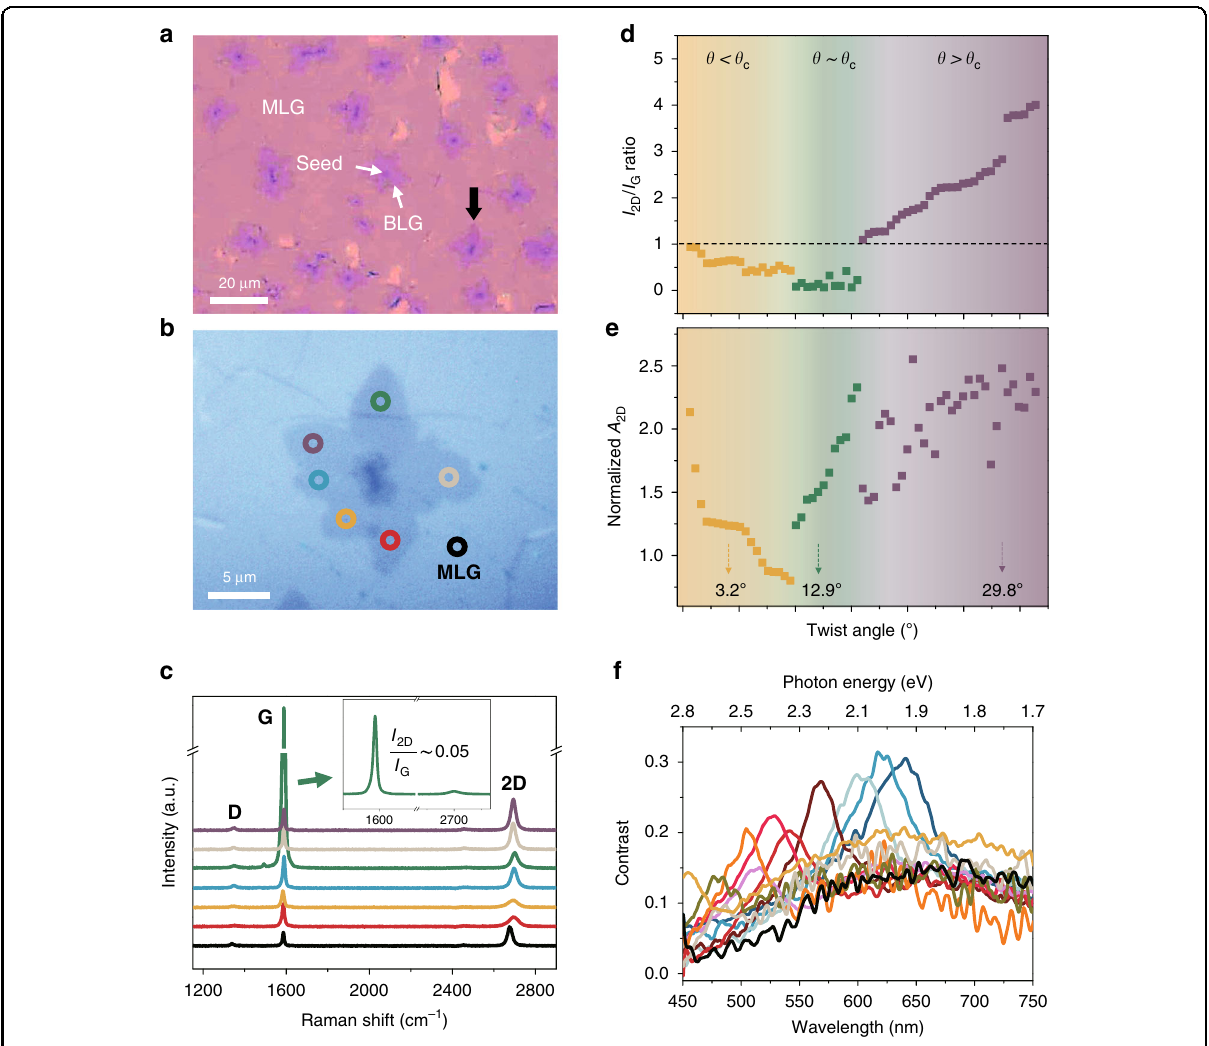
Fig. 1 Optical and Raman characteristics of CVD-grown tBLG. a Microscope image of CVD-grown graphene transferred onto a 300 nm SiO 2 /Si substrate. MLG covers most of the silica area with locally distributed star-shaped tBLG centred at the seeds (the darkest spots in the image). b Enlarged microscope image of the tBLG indicated by the black downward arrow in ( a ). Colour circles represent individual tBLG regions according to the twist angles. The black-circled region represents MLG. c Raman spectra of tBLG marked with the same colour as the circles in ( b ). Inset: Raman spectrum showing the full G- and 2D-bands in the green-circled tBLG in ( b ), where Raman G-resonance occurs from the interaction with the 532 nm excitation laser, indicating that the twist angle should be 12 ± 1° (refs. 29,33 ) (the critical angle, θ c , regime). Various Raman signals measured in 63 tBLG regions ( d 2D/G peak ratio, and e 2D-band area normalized by that of MLG) were used to classify the twist angle of tBLG. For clarity, tBLG regions with θ < θ θ ∼ θ θ > θ c , c , and c are represented by orange-, green- and purple-coloured sections, respectively. f Linear absorption contrast spectra in tBLG on a 100 nm SiO 2 /Si